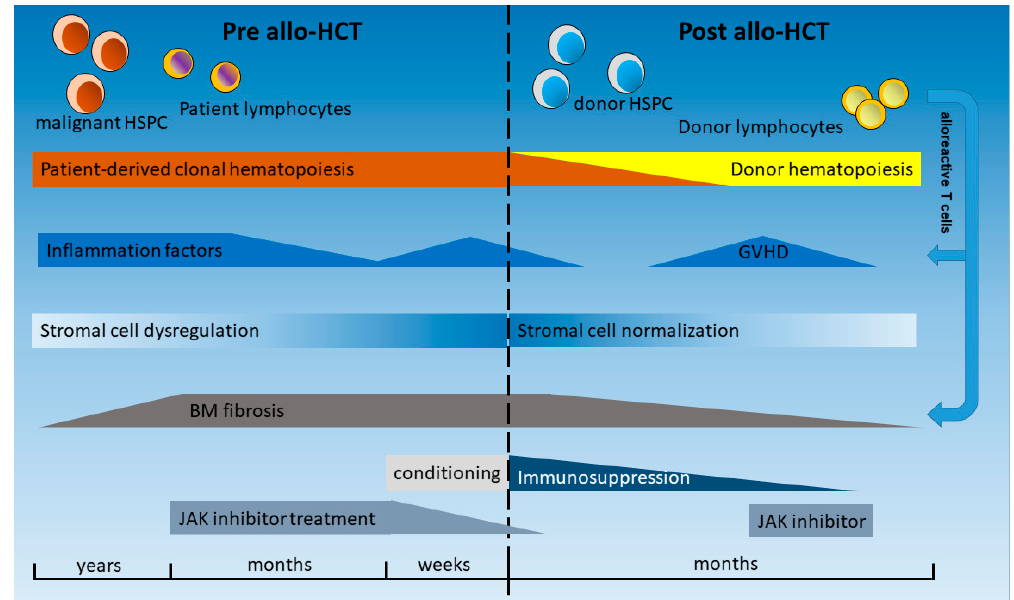
Figure 2. Order of events in the bone marrow (BM) before and after allogeneic hematopoietic stem cell transplantation (allo-HCT) in myelofibrosis. The malignant hematopoietic clone is considered as the origin of subsequent inflammatory alterations and modifications of stromal cells and the extracellular matrix [35]. These alterations finally lead to BM fibrosis [1]. Treatment with JAK inhibitors, such as ruxolitinib, can significantly decrease inflammation but, in most cases, not fibrosis [77,78]. The termination of ruxolitinib treatment and the conditioning regimen before HCT may induce a new increase in inflammation factors and ruxolitinib withdrawal syndrome [79] or sinusoidal obstructive syndrome [80]. After HCT, the elimination of the malignant clone and subsequent replacement by normal donor hematopoietic stem and immune effector cells typically lead to a persistent decrease in inflammation factors [74]. Over time, stromal cells often regain normal functionality, with normalization of extracellular matrix deposition and disappearance of fibrosis. Immunosuppressive medication will be tapered over time and stopped in the majority of patients. However, graft-versus-host disease (GVHD) can lead to an increase of inflammation factors, many of which are similar to the MPN-associated cytokines, albeit without an increase in fibrosis. Accordingly, JAK inhibitors can be used as immunosuppressive drugs in patients with refractory GVHD [81].